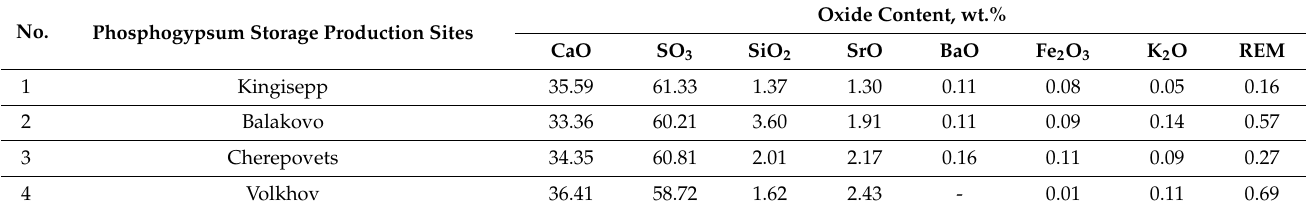
Table 1. The chemical composition of phosphogypsum from different storage dumps in